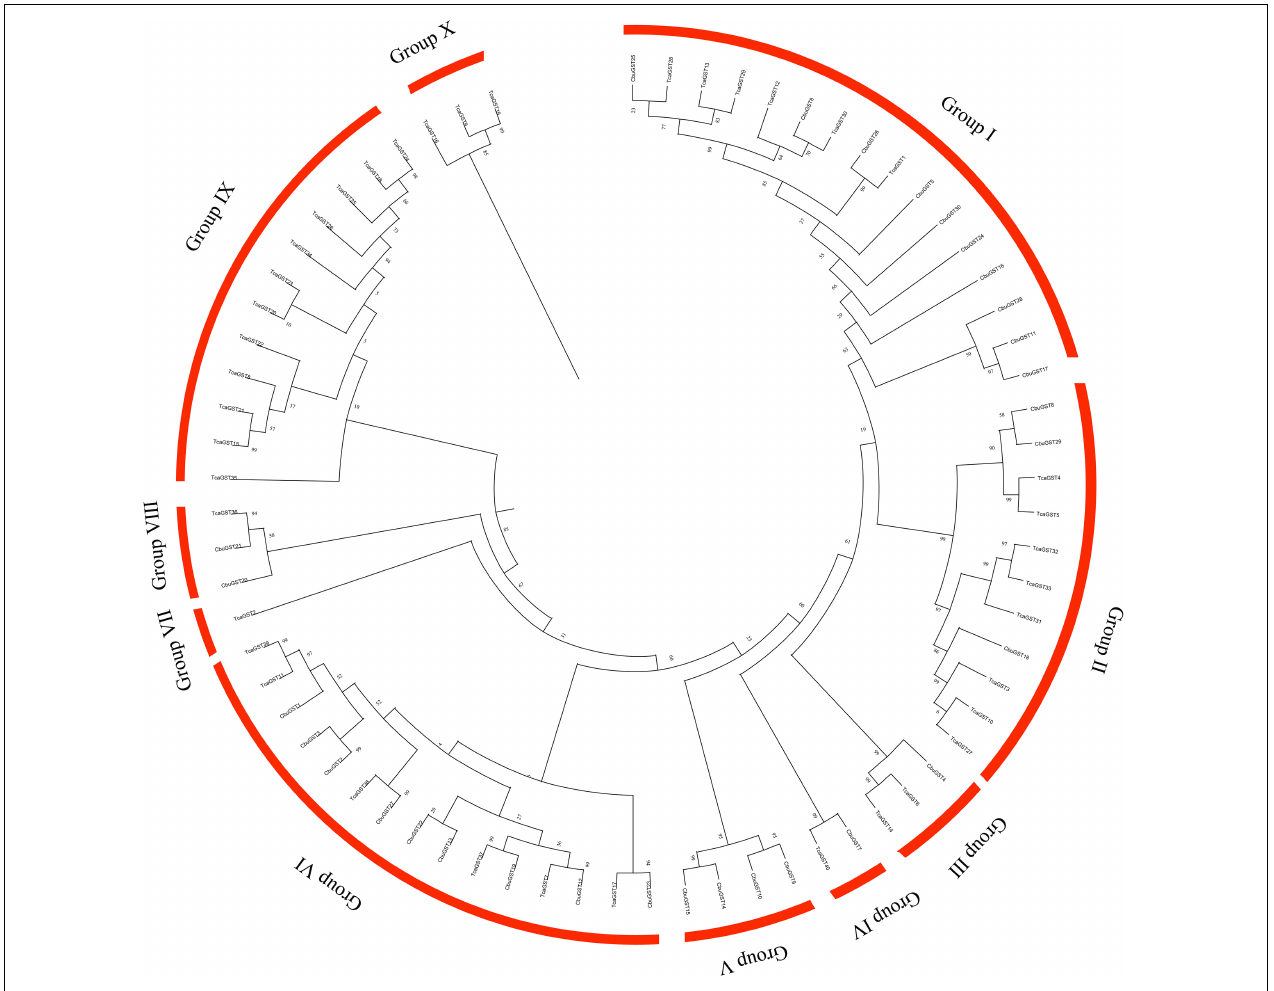
FIGURE 6 | Phylogenetic tree of GSTs (glutathione S-transferases) in C. buqueti ( C. buqueti , Cbu) and red flour beetle ( T. castaneum , Tca)